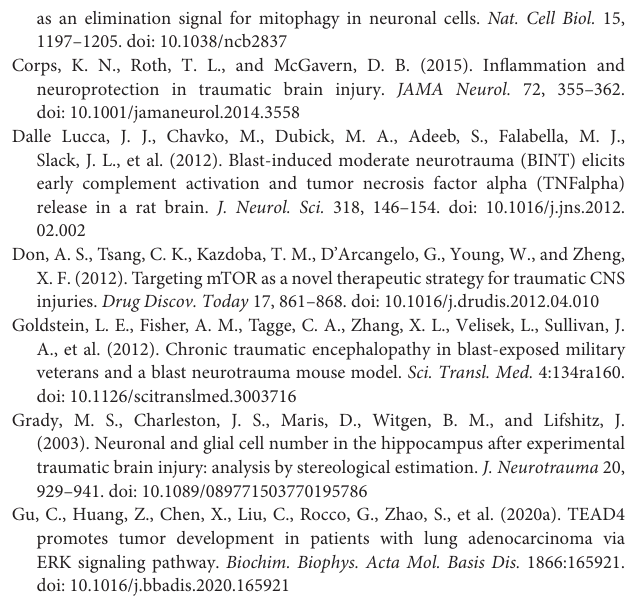
Supplementary Figure 1 | The differential expression of hub genes between TBI and control in GSE89866. ∗ P < 0.05, ∗∗ P < 0.01, ∗∗∗ P < 0.001. Supplementary Table 1 | The differentially expressed genes in GSE89866. Supplementary Table 2 | The differentially expressed genes in